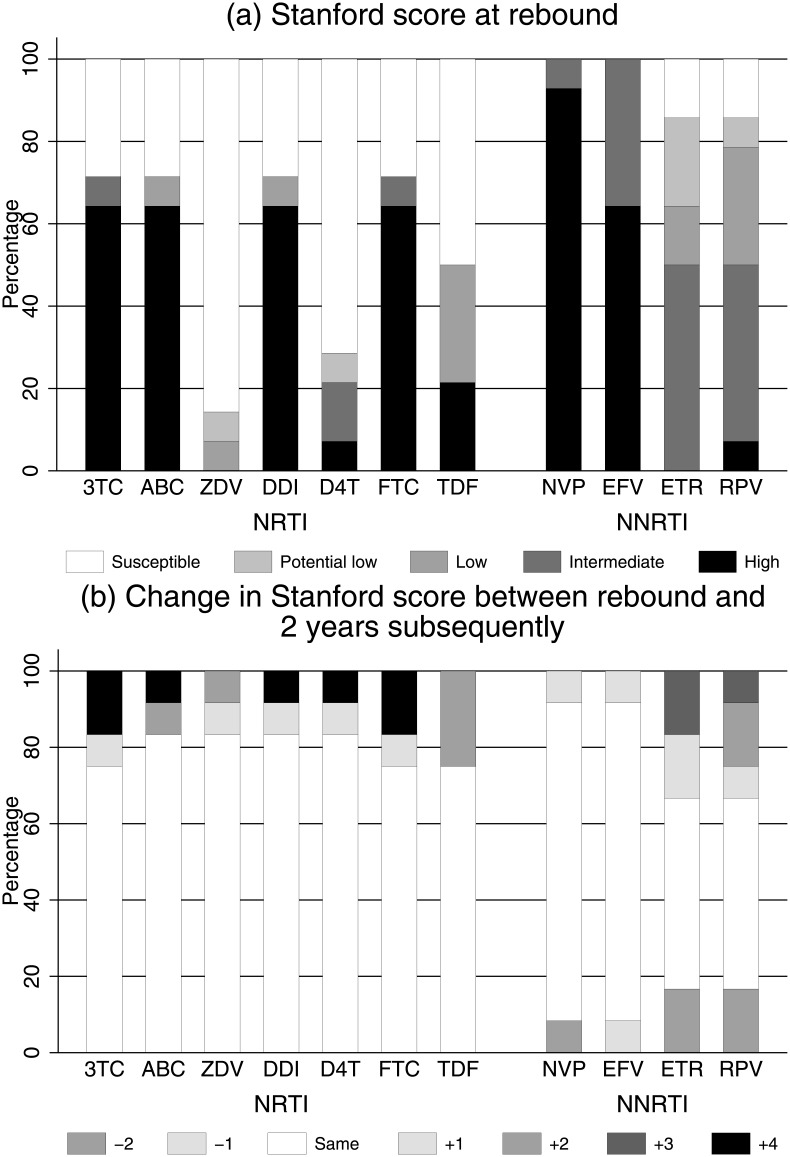
(a) Predicted drug susceptibility at rebound and (b) change in susceptibility over a median 2 years in those randomised to 2NRTI+NNRTI maintenance (n = 12).Abbreviations: 3TC, lamivudine; ABC, abacavir; D4T, stavudine; DDI, didanosine; EFV, efavirenz; ETR, etravirine; FTC, emtricitabine; NNRTI, non-nucleoside reverse transcriptase inhibitor; NRTI, nucleoside reverse transcriptase inhibitor; NVP, nevirapine; RPV, rilpivirine; TDF, tenofovir; ZDV, zidovudine.